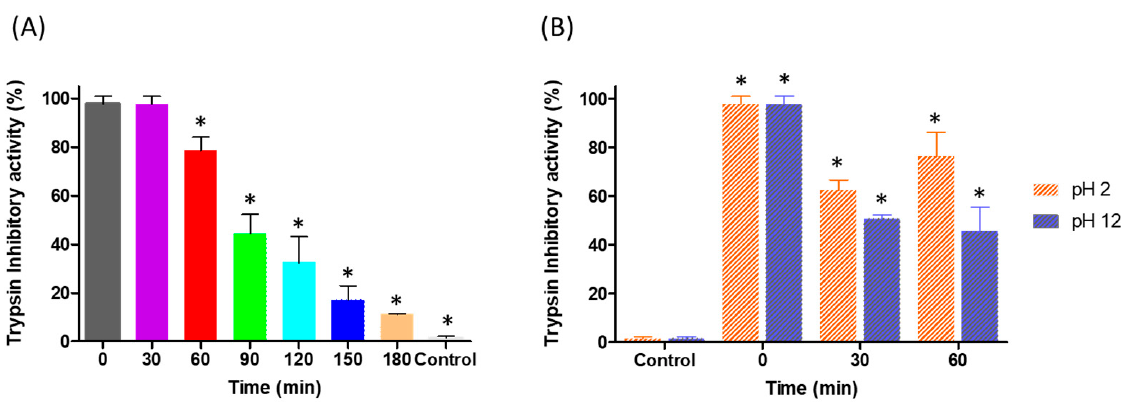
Figure 2. Physicochemical stability of YBPTI. ( A ) Effect of temperature and ( B ) pH treatment on the trypsin inhibitory activity of YBPTI. In ( A ), the asterisk (*) indicates significantly different compared to time 0. In ( B ), the asteric (*) indicates significantly different compared to control conditions. In both cases, a one-way ANOVA ( p < 0.05) and Tukeýs multiple comparison test was performed.